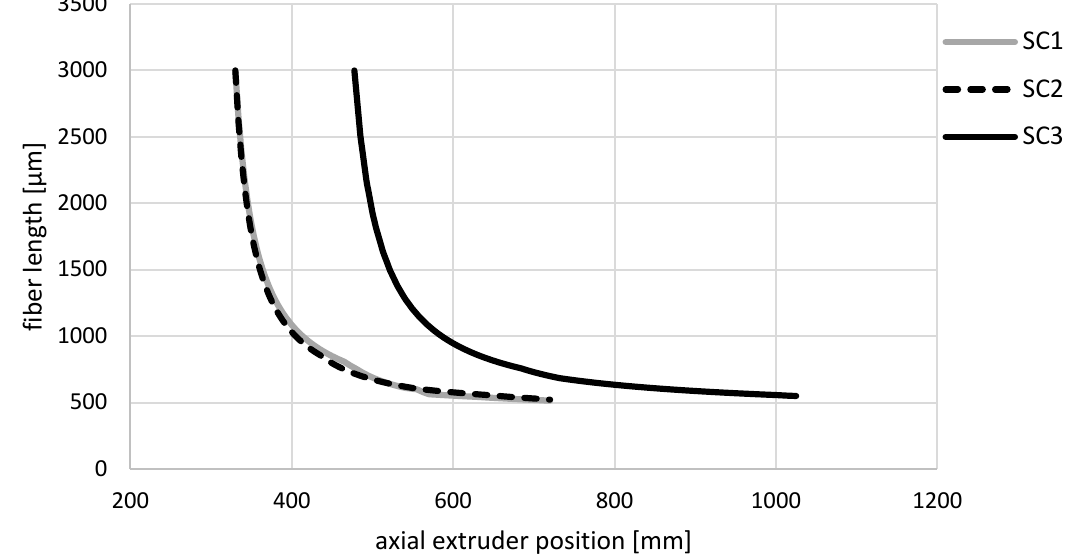
Figure 6. Simulated fiber length curves for the glass fiber content of 20 wt.% for the three different screw configurations along the axial extruder position.